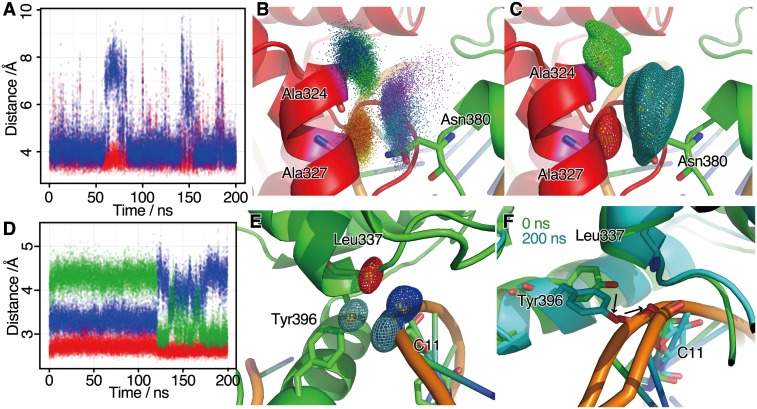
Examples of transiently formed intermolecular interactions.(A, B, and C) Interactions among the Nδ atom of the Asn380B side-chain, and the Cβ atoms of Ala324A and Ala327A. (A) The time course of interatomic distances, where red and blue plots denote Ala324A–Asn380B and Ala327A–Asn380B, respectively. (B) Spatial distributions of the coordinates of the three atoms. Color gradations of the plots, green to blue, yellow to red, and cyan to magenta, correspond to the time evolution of the simulation from 10 to 200 ns, for Ala324A, Ala327A, and Asn380B, respectively. (C) Contours of probability density functions of the Gaussian mixture models learned from the distributions in (B). The green, red and cyan meshes denote the contours for Ala324A, Ala327A, and Asn380B, respectively. (D, E, and F) Interactions among the Oη atom of Tyr396B, the backbone nitrogen atom of Leu337B, and an oxygen atom of the phosphate group of C11. (D) Time course of interatomic distances, where red, blue, and green plots denote Tyr396B–C11, Leu337B–Tyr396, and Leu337B–C11 pairs, respectively. (E) Contours of probability density functions of the Gaussian mixture models. The cyan, red, and blue meshes denote the contours of Tyr396B, Leu337B, and C11, respectively. (F) Snapshots at 0 ns (green) and 200 ns (cyan). The structures of the three residues focused on here are shown as sticks.